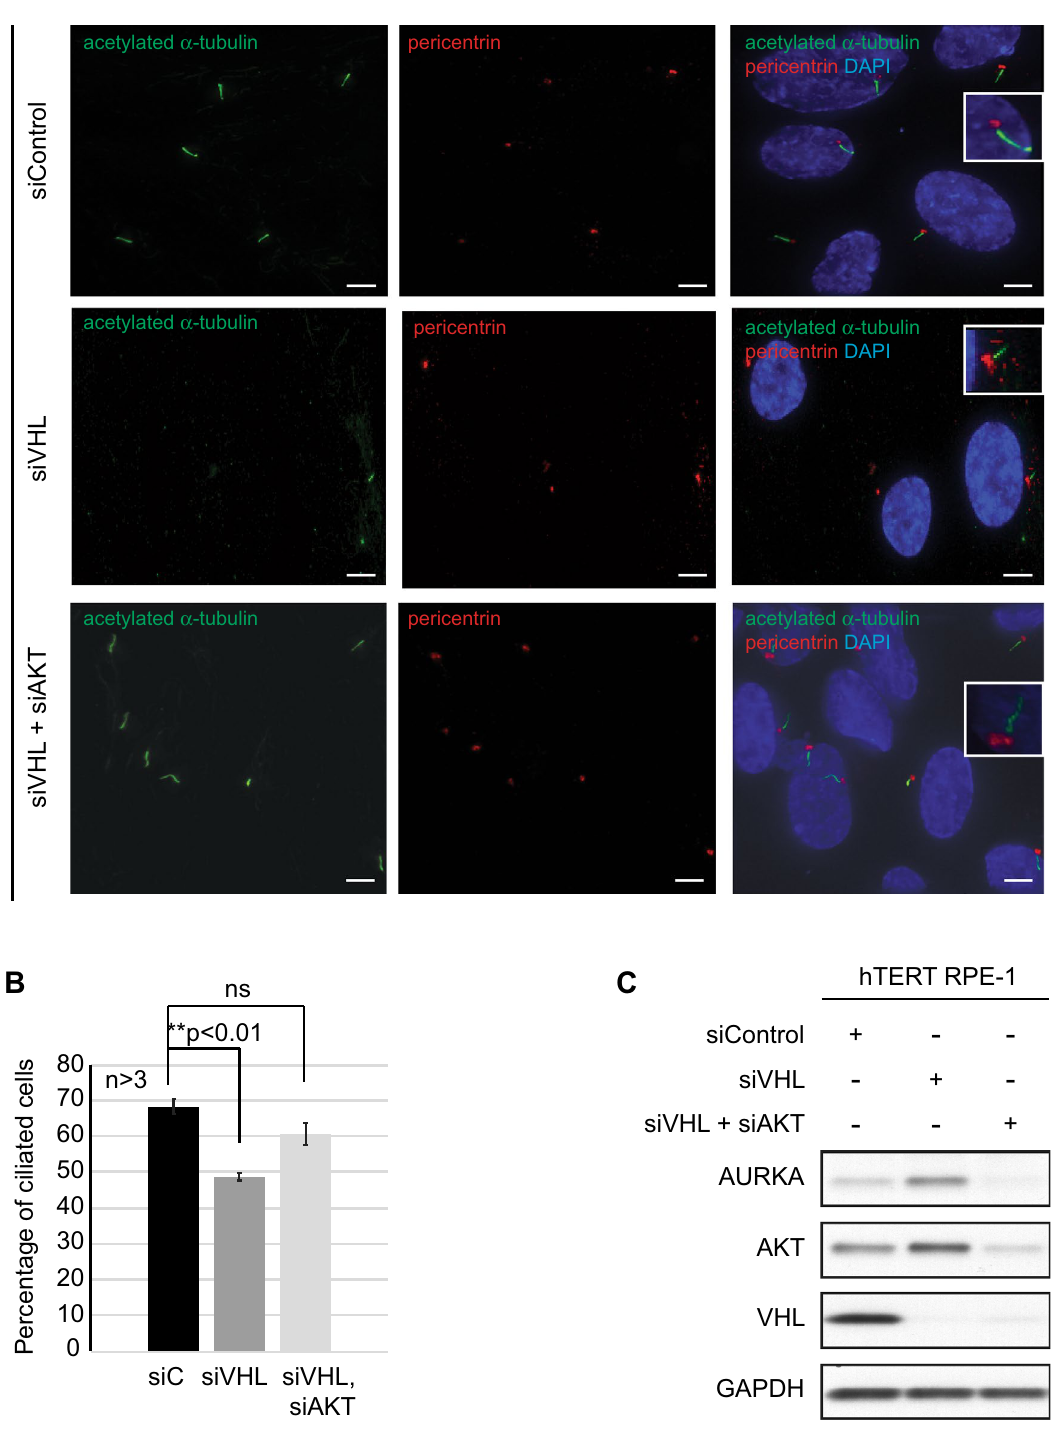
Figure 4. Co-deletion of AKT and VHL rescues ciliogenesis. ( A ) Representative images of hTERT RPE-1 cells (60X magnification) transfected with siC (scrambled control), siVHL or co-transfected with siVHL and siAKT showing acetylated α-tubulin (cilia marker, green) and pericentrin (basal body marker, red). Nuclei are counterstained with DAPI in blue. Insets show a magnified image of a cilium for each of the treatment conditions. Scale bar, 10 μM. ( B ) Graphical representation of the percentage of ciliated cells for each of the treatments as indicated in VHL -proficient (siC, black line) and VHL -deficient (gray line) cells. **Statistical significance (Students t-test) compared to vehicle (DMSO) treated controls with indicated p-values. ( C ) Whole cell extracts from hTERT RPE-1 cells transfected with siC, siVHL or co-transfected with siVHL and siAKT, immunoblotted using antibodies